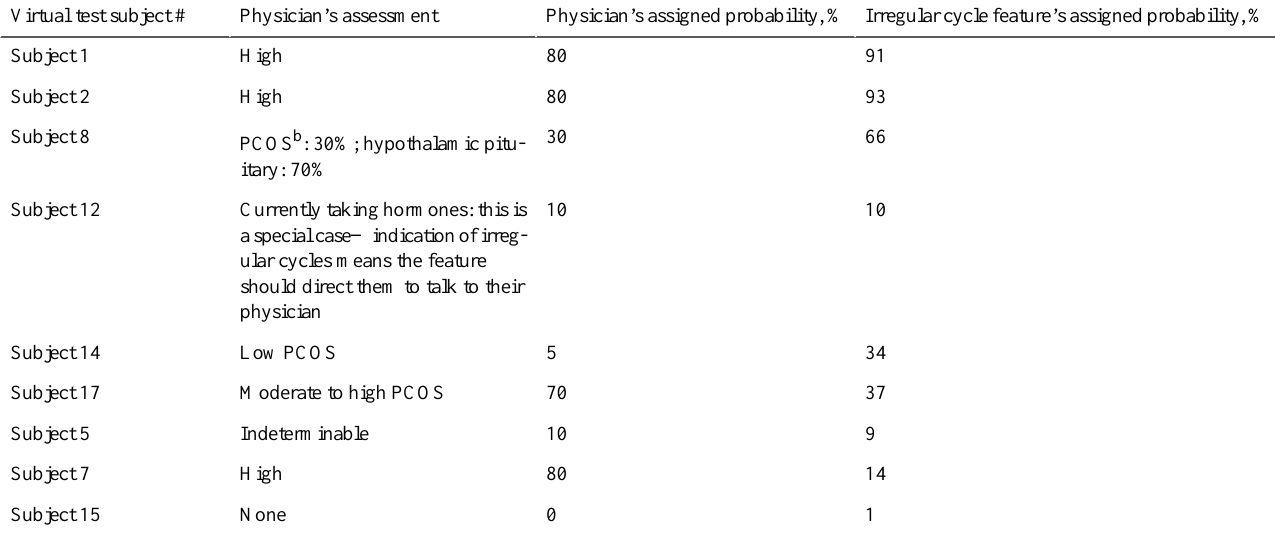
Table 1. Probability assignments